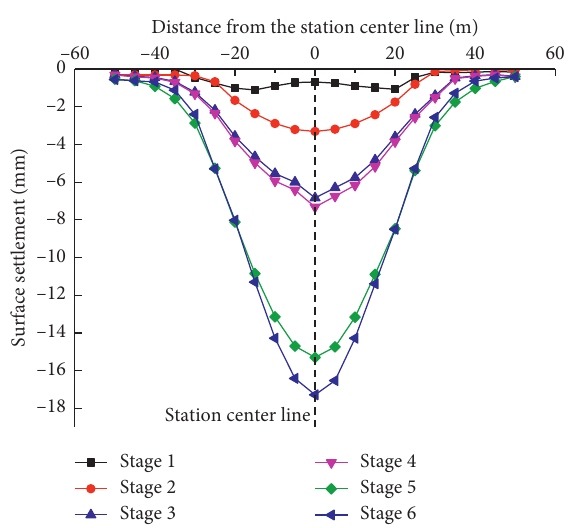
Figure 10: The surface settlement at different construction